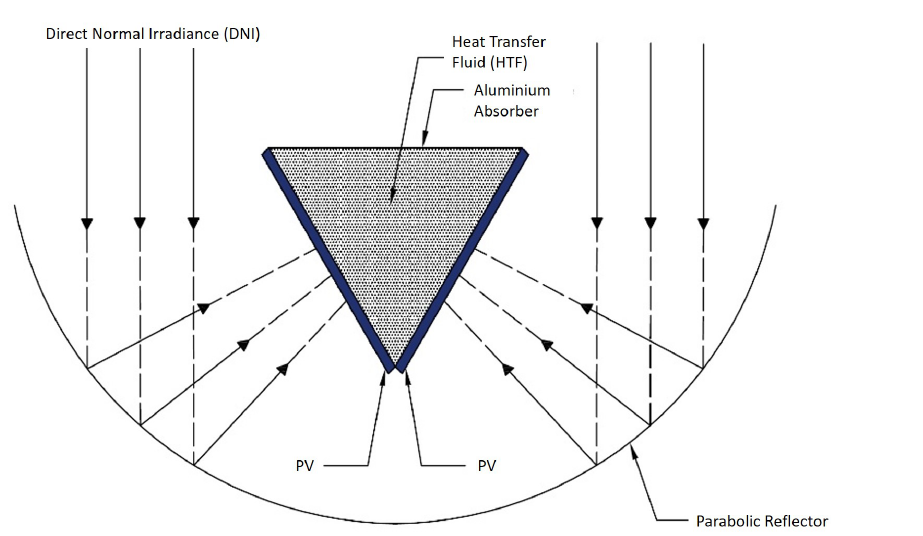
Figure 1. Diagram of CPVT module